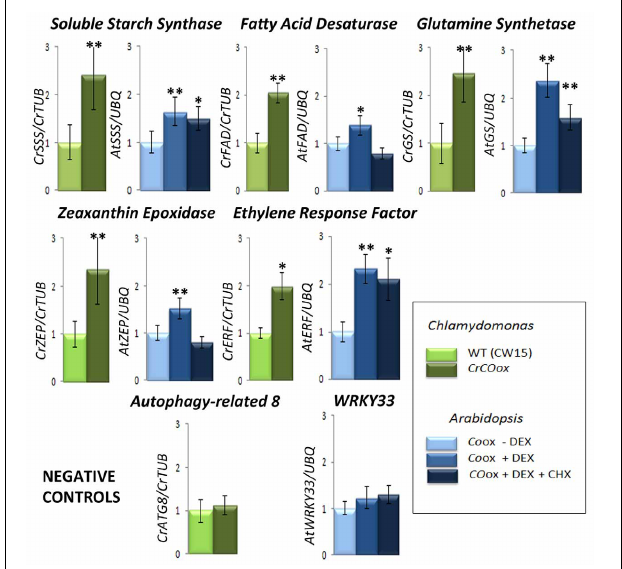
FIGURE 4 | Genes within the COL co-expression network are influenced through evolution by COL overexpression. The bars represent Q-PCR expression levels of some representative genes within the influence of COLs in the networks of Figure 2 . The results for gene homologues of Soluble Starch Synthase ( SSS ), Fatty Acid Desaturase ( FAD ), Glutamine Synthetase ( GS ), Zeaxanthin Epoxidase ( ZEP ), and Ethylene Response Factor ( ERF ) in Chlamydomonas (in green) and Arabidopsis (in blue) are presented. Two control genes, ATG8 from Chlamydomonas and WRKY33 from Arabidopsis that show no correlation with either CrCO or any AtCOL respectively, were chosen as negative controls. Light green bars represent relative gene expression levels in wild type ( CW15 ) Chlamydomonas while dark green represent CrCO ox algae results. Light blue bars represent relative gene expression levels in 35S: CO -GR Arabidopsis plants without chemical addition; medium blue bars represent the same in the presence of DEX and dark blue in the presence of DEX and CHX. Data are the mean of 4 independent experiments relative to control genes and include s.e.m. Two asterisks above a bar represent a fold change with 95% significance, while a single asterisk represents a fold change with 90%